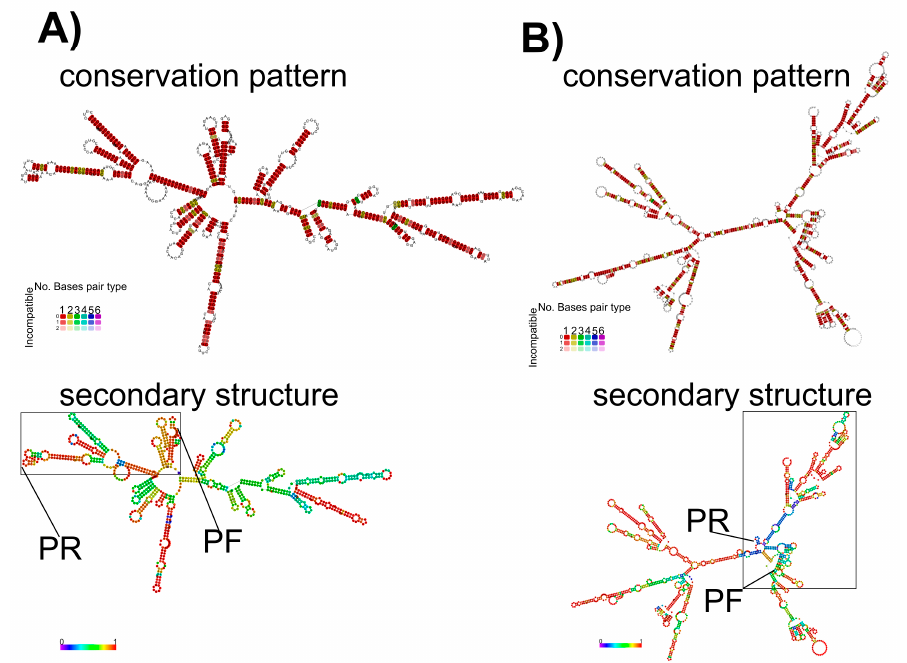
Figure 3. Comparison of the probability of folding for secondary structures. ( A ) Secondary structure folding and conservation pattern of pairing for M gene. The target region framed by M+25 and M-124 primers is denoted by a rectangle, and the hybridization region for each primer is highlighted. ( B ) Secondary structure folding and conservation pattern of pairing for HA gene. The target region framed by H155f and H699r is denoted by a rectangle and the hybridization region for each primer is highlighted. In the upper panels, the color scale indicates level of conservation and in the lower panels the bar indicates the scale of probability for folding.